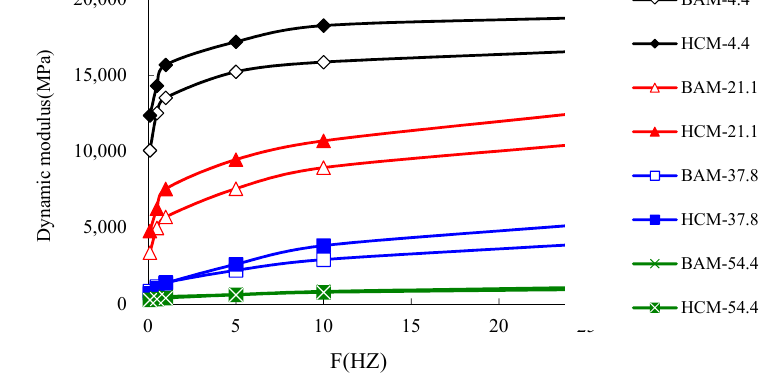
Figure 9. Dynamic moduli of mixtures.